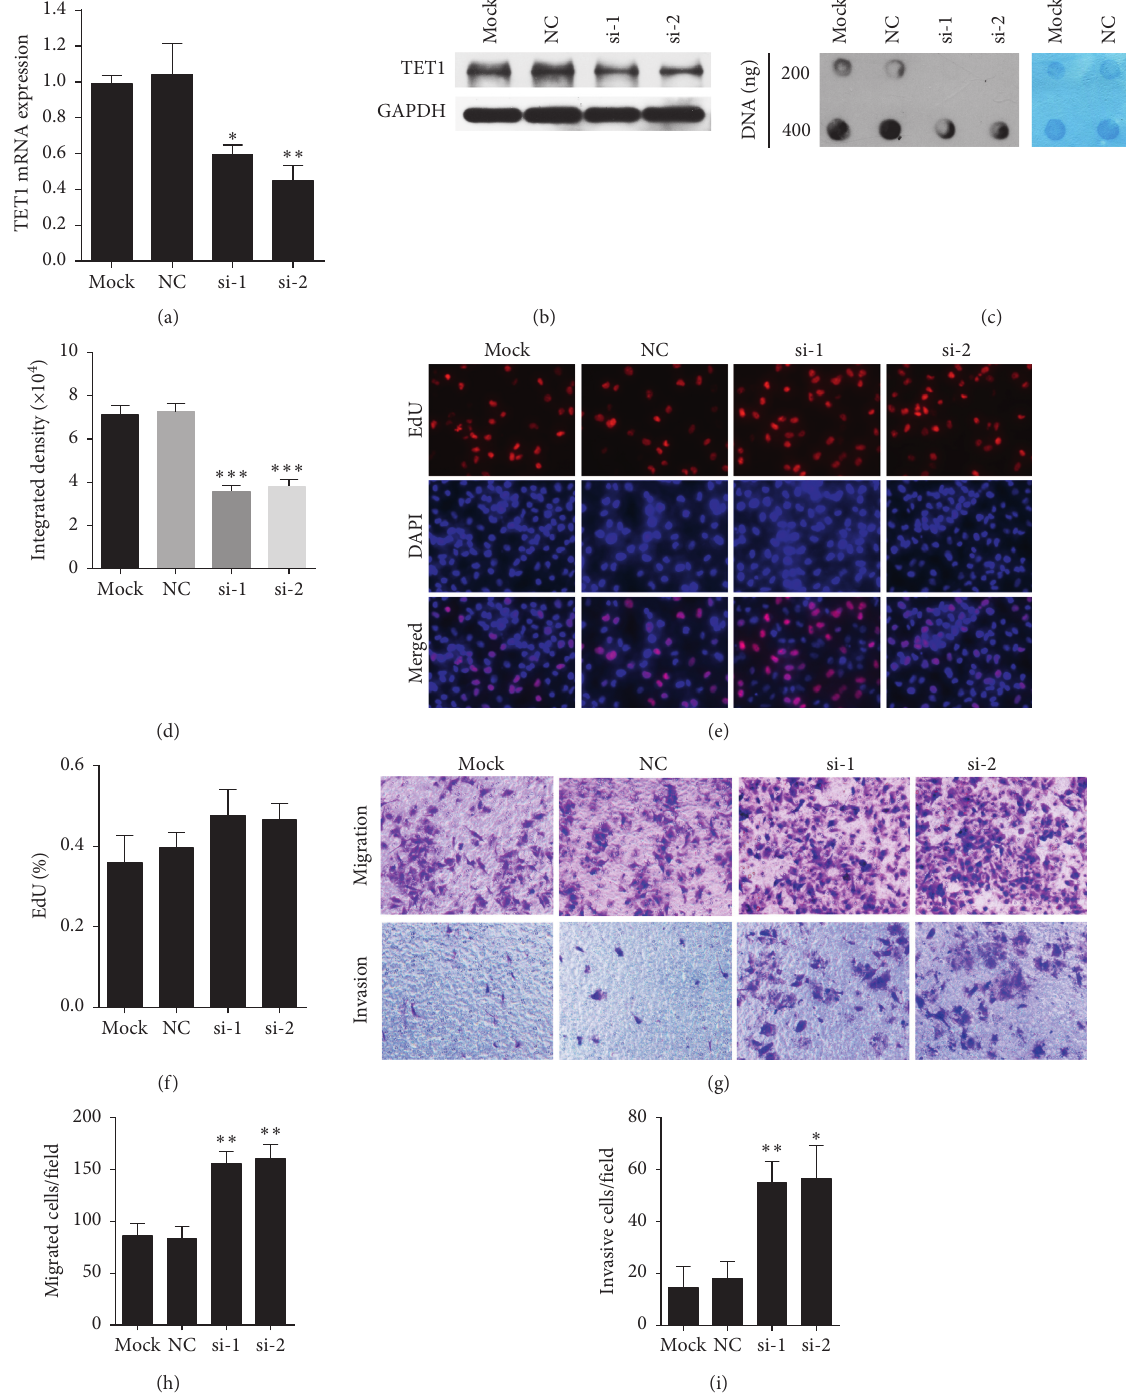
Figure 3: TET1 inhibited the invasion and migration in BCPAP cells. (a, b) TET1 level significantly declined after transfection with si-TET1 RNAs as detected using qRT-PCR and Western blot assays. (c) Dot blot assay showed the expression of 5hmC after 48h of transfection of si- TET1 RNAs (left). Methylene blue staining of the identical membrane was used as the sample control (right). (d) ImageJ software was used to analyze exposure grayscale and showed that the downregulated TET1 expression level was consistent with the reduction in the 5hmC level. (e) EdU incorporation assay was conducted to examine the potential role of TET1 in cell proliferation after si-TET1 and si-TET2 transfection. Fluorescent images of proliferative cells (red) stained with EdU and nuclei (blue) counterstained with DAPI in BCPAP cells. Magnification, 400x. (f) Quantification of EdU incorporation assay in BCPAP cells. (g) Transwell migration and invasion assays of BCPAP cells after si-TET1 and si-TET2 transfection were performed without and with the Matrigel-coated chamber. Magnification, 200x. (h) Quantification of migrated cells. (i) Diagrams of invasive cells. ∗ P < 0 . 05, ∗∗ P < 0 . 01, and ∗∗∗ P < 0 .